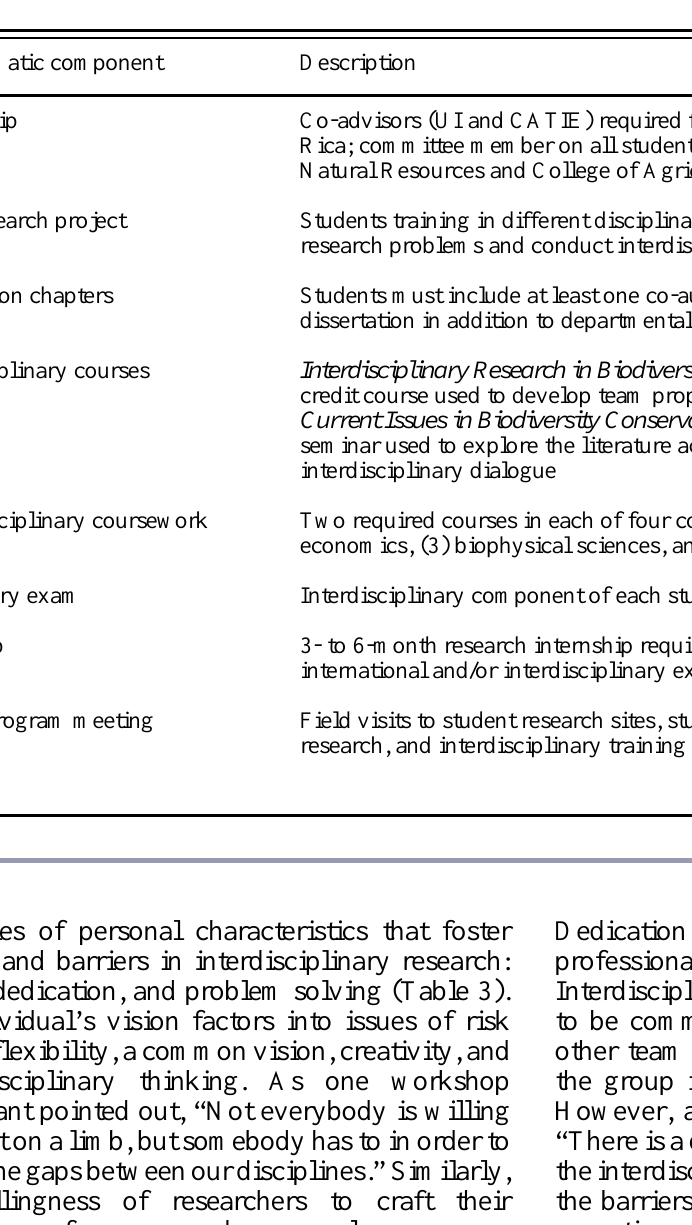
Table 2 . Academic structure of the University of Idaho (UI)-Tropical Agricultural Research and Higher Education Center (CATIE) Integrative Graduate Education and Research Traineeship program (University of Idaho-CATIE